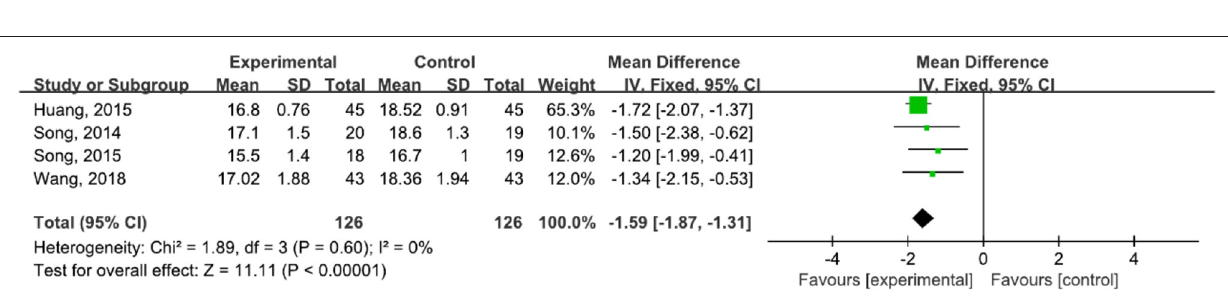
FIGURE 10 | Forest plot showing MD (with 95% CI) for PDRS-II of the included studies comparing the experimental and control groups.